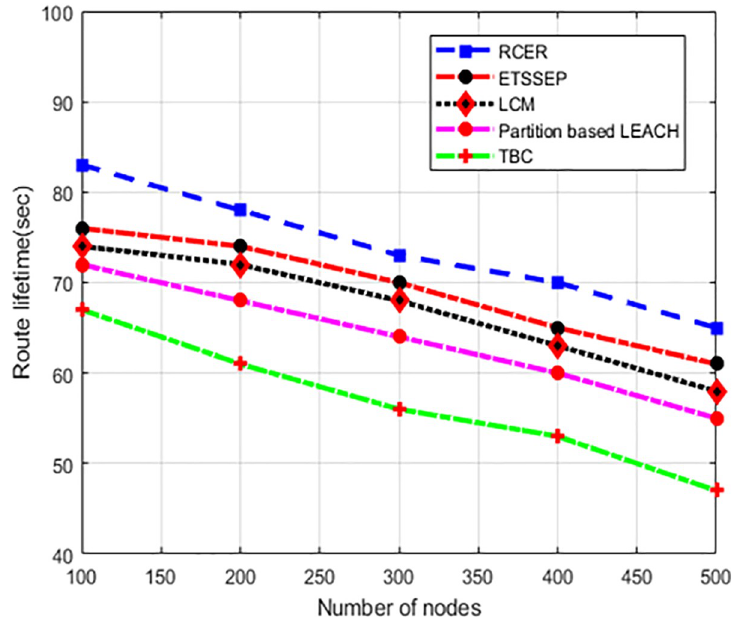
Fig 16. Route lifetime in high-density